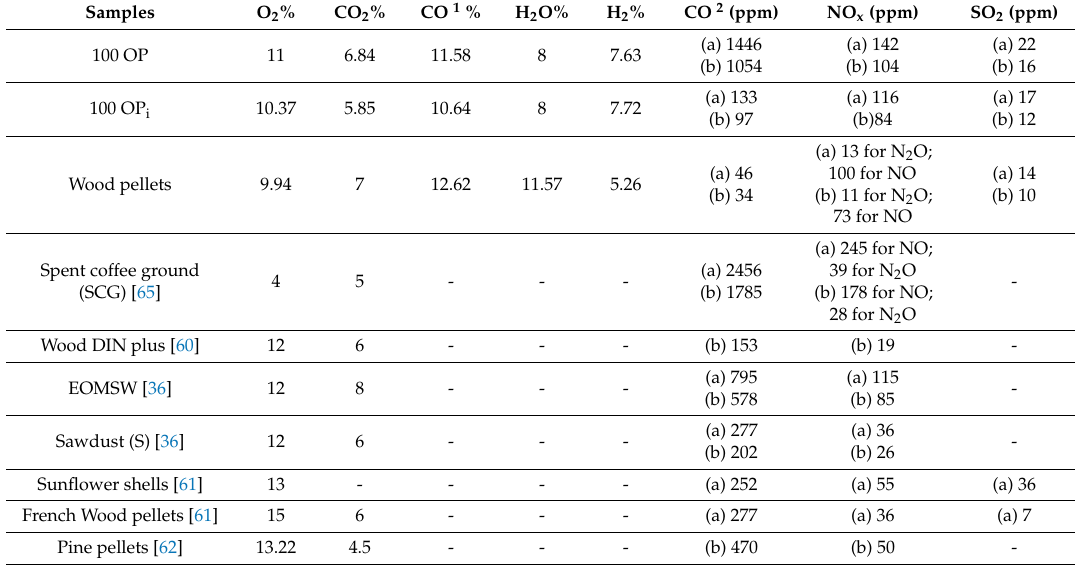
Table 7. Emissions values corrected at respectively; (a) 10% O 2 and (b) 13% O